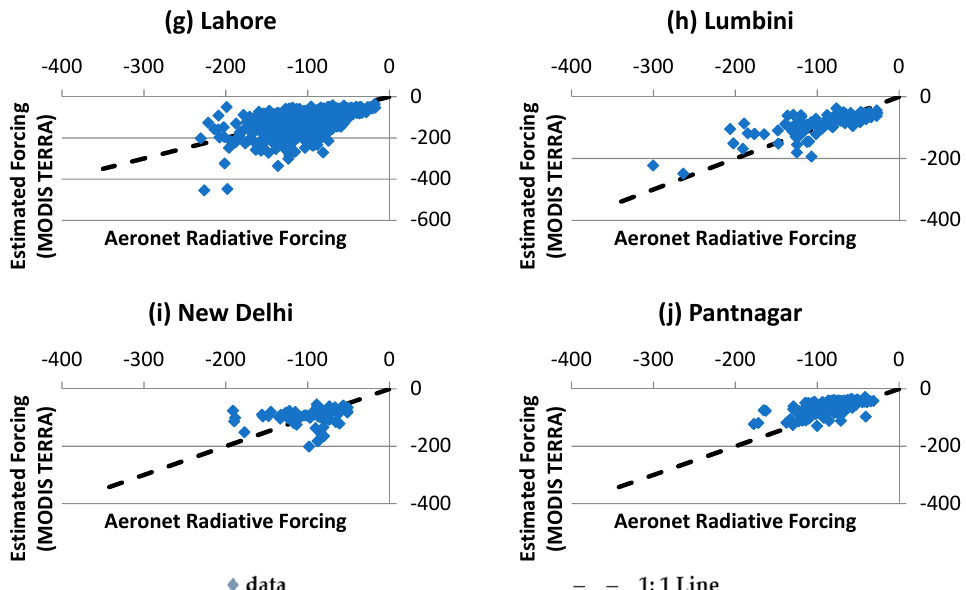
Figure 4. Comparison of estimated radiative forcing by using MODIS Terra derived AOD and atmospheric water vapour with AERONET radiative forcing in the stations of IGP. ( a ) Bhola ( b ) Dhaka University ( c ) Gandgi Colleague ( d ) Kanpur ( e ) Karachi ( f ) Kolkata ( g ) Lahore ( h ) Lumbini ( i ) New Delgi ( j ) Pantnagar. Table 10. Evaluation of the model with AOD and precipitable water vapour retrieved from MODIS Terra in the IGP. Number of Mean Error RMSE Correlation SN Row Labels Observations (Wm − 2 ) (Wm − 2 ) Coefficient,